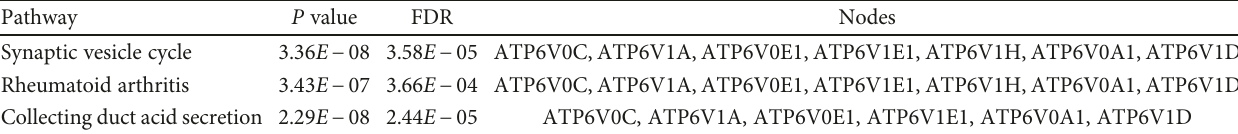
Table 3: The enriched pathways for genes in the highest